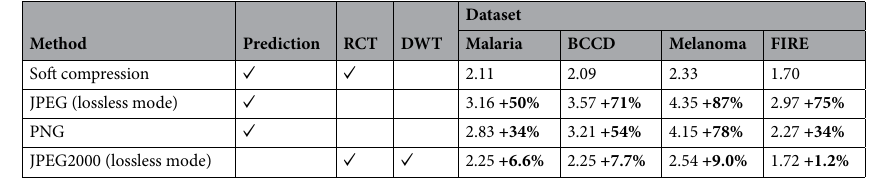
Table 3. Compression performance of soft compression and baselines, in bits per sub-pixel (bpsp). We emphasize the difference in percentage to soft compression for each other method in bold if soft compression outperforms the other method (RCT and DWT refer to reversible component transformation and discrete wavelet transform